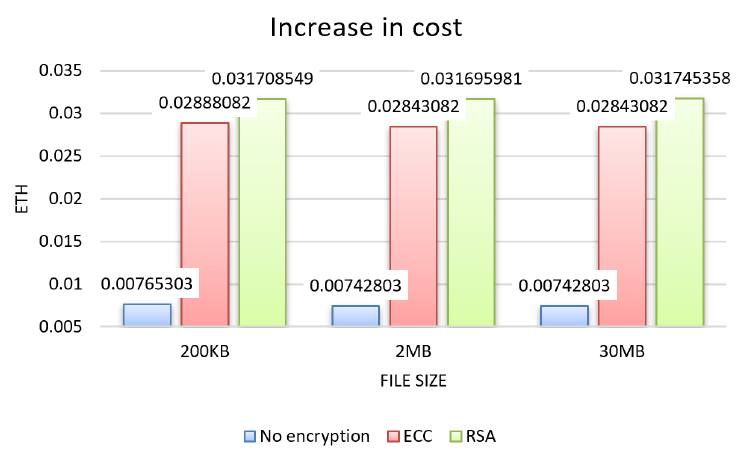
Figure 6. Increase in cost.